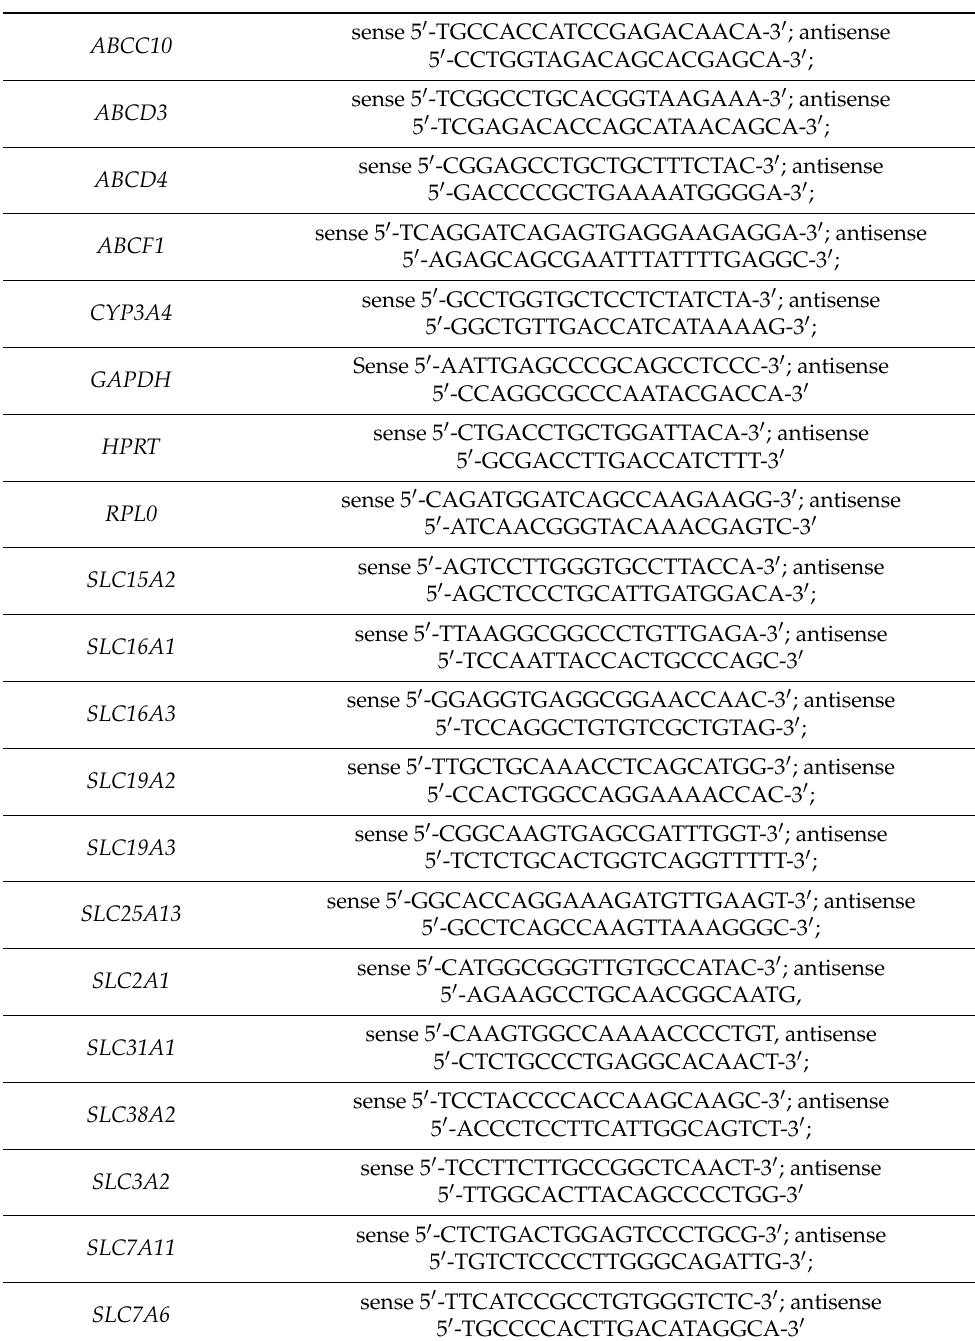
In order to screen for drug transporter genes differentially expressed between 22Rv1 cells overexpressing hPXR and control cells, we used the RT 2 Profiler™ PCR Array Hu- man Drug Transporters from Qiagen (Cat No./ID: PAHS-070ZF-2) and the RT 2 SYBR Green qPCR Mastermix (Cat No./ID: 330500) for first strand cDNA synthesis reactions using the protocol recommended by the manufacturer (RT 2 Profiler PCR Array Handbook dated